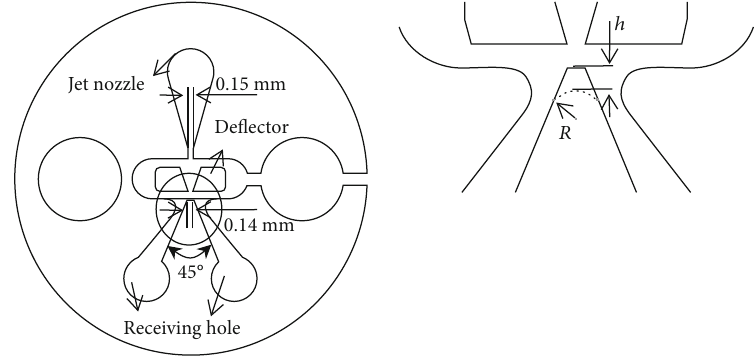
Figure 4: Diagram of pilot stage ’ s erosion wear.